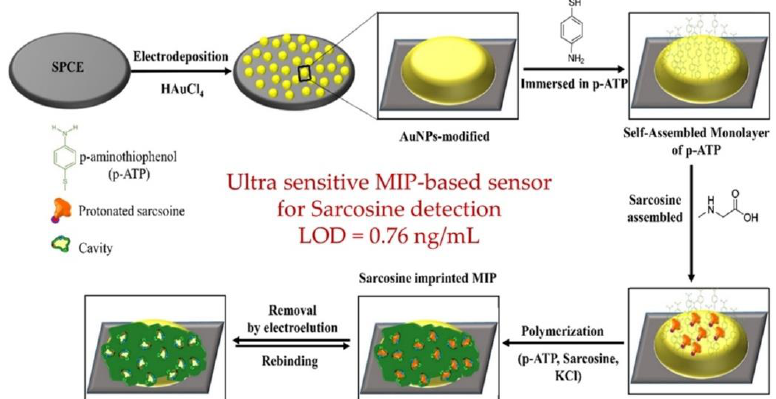
Figure 4. Schematic diagram of the sensing platform produced by Nguy et al. utilising a screen- printed carbon electrode (SPCE) functionalized with AuNPs and poly(4-aminophenol) imprinted with sarcosine. Reprinted from Sensors and Actuators B: Chemical, 246, Nguy et al., Development of an impedimetric sensor for the label-free detection of the amino acid sarcosine with molecularly imprinted polymer receptors., 461 – 470, 2017, with permission from Elsevier.